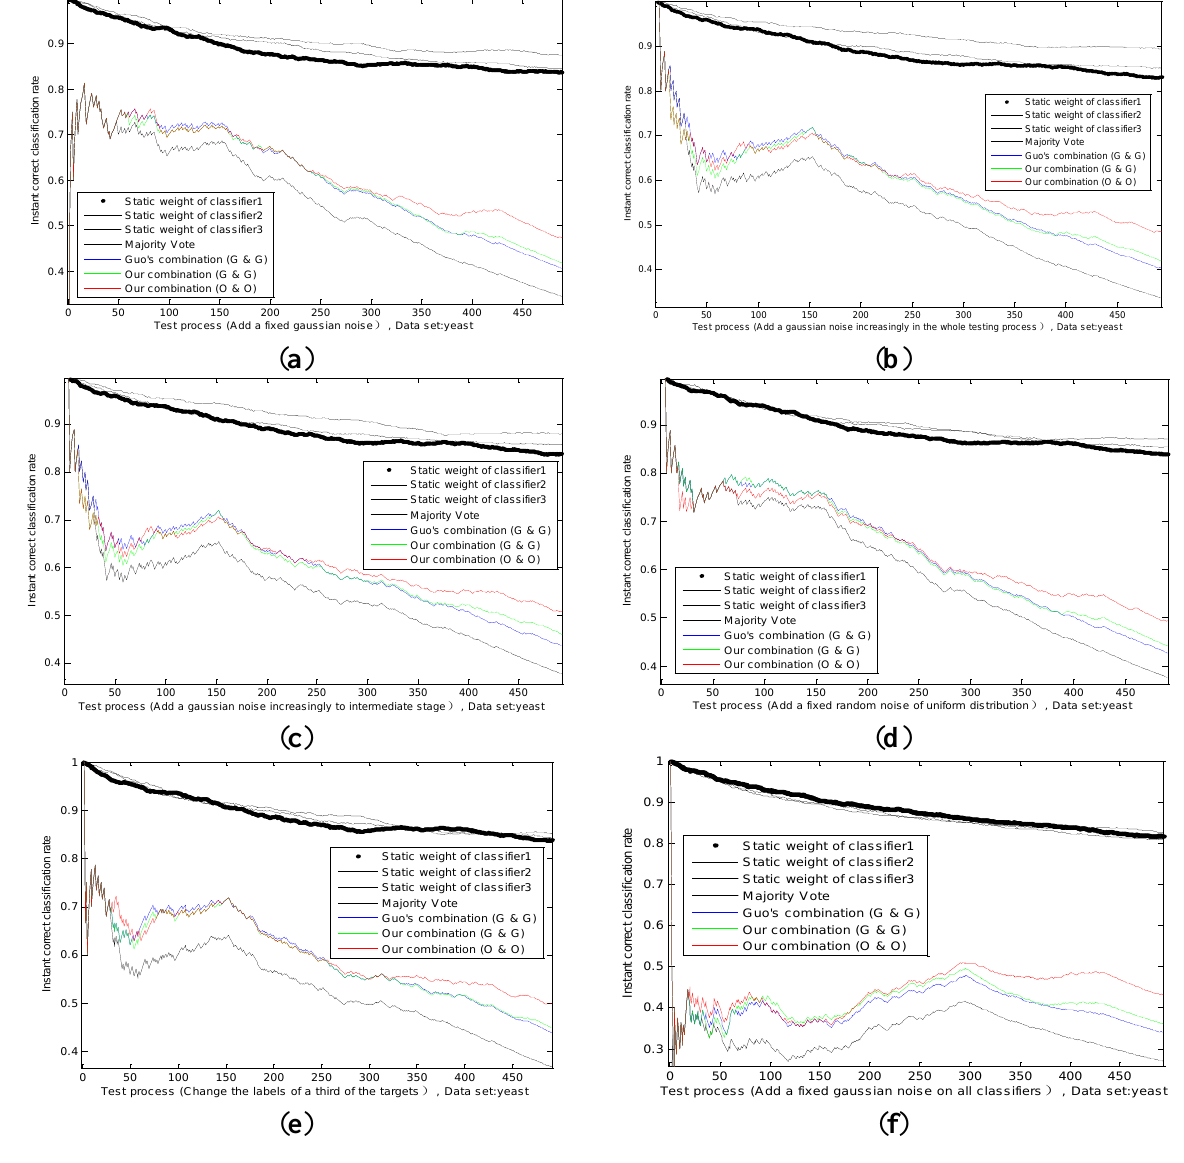
Figure 8. Instant results of different methods in the whole test process on different conditions. Add a fixed Gaussian noise on classifier 1 ( a ), Add a Gaussian noise on classifier 1 increasingly in the whole testing process ( b ), Add a Gaussian noise on classifier 1 increasingly to intermediate stage ( c ), Add a fixed random noise of uniform distribution on classifier 1 ( d ), Change partial labels of the targets of classifier 1 ( e ), Add a fixed Gaussian noise on all classifiers ( f